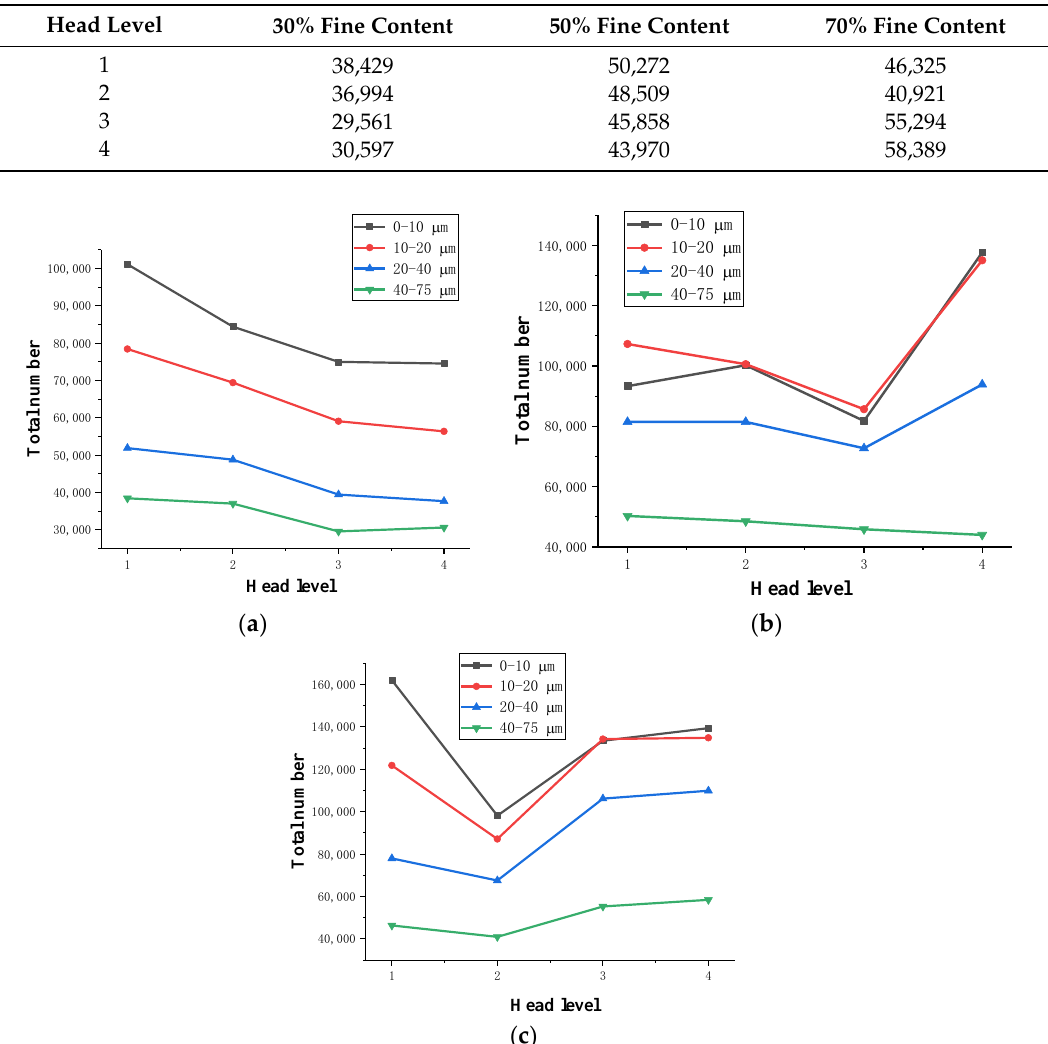
Table 21. Fine particle content change during seepage (20 – 40 µm).